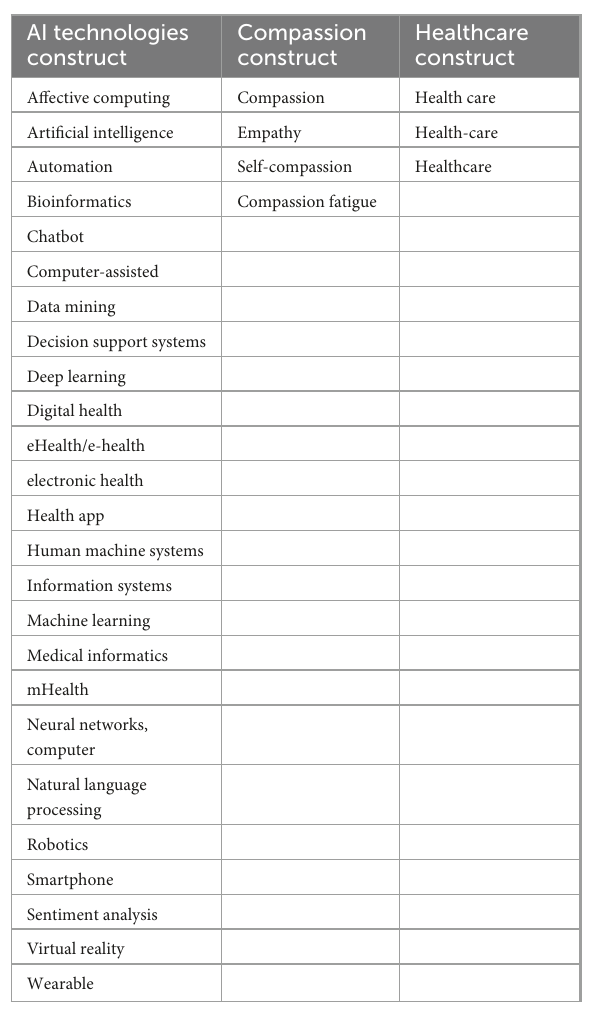
AI technologies construct